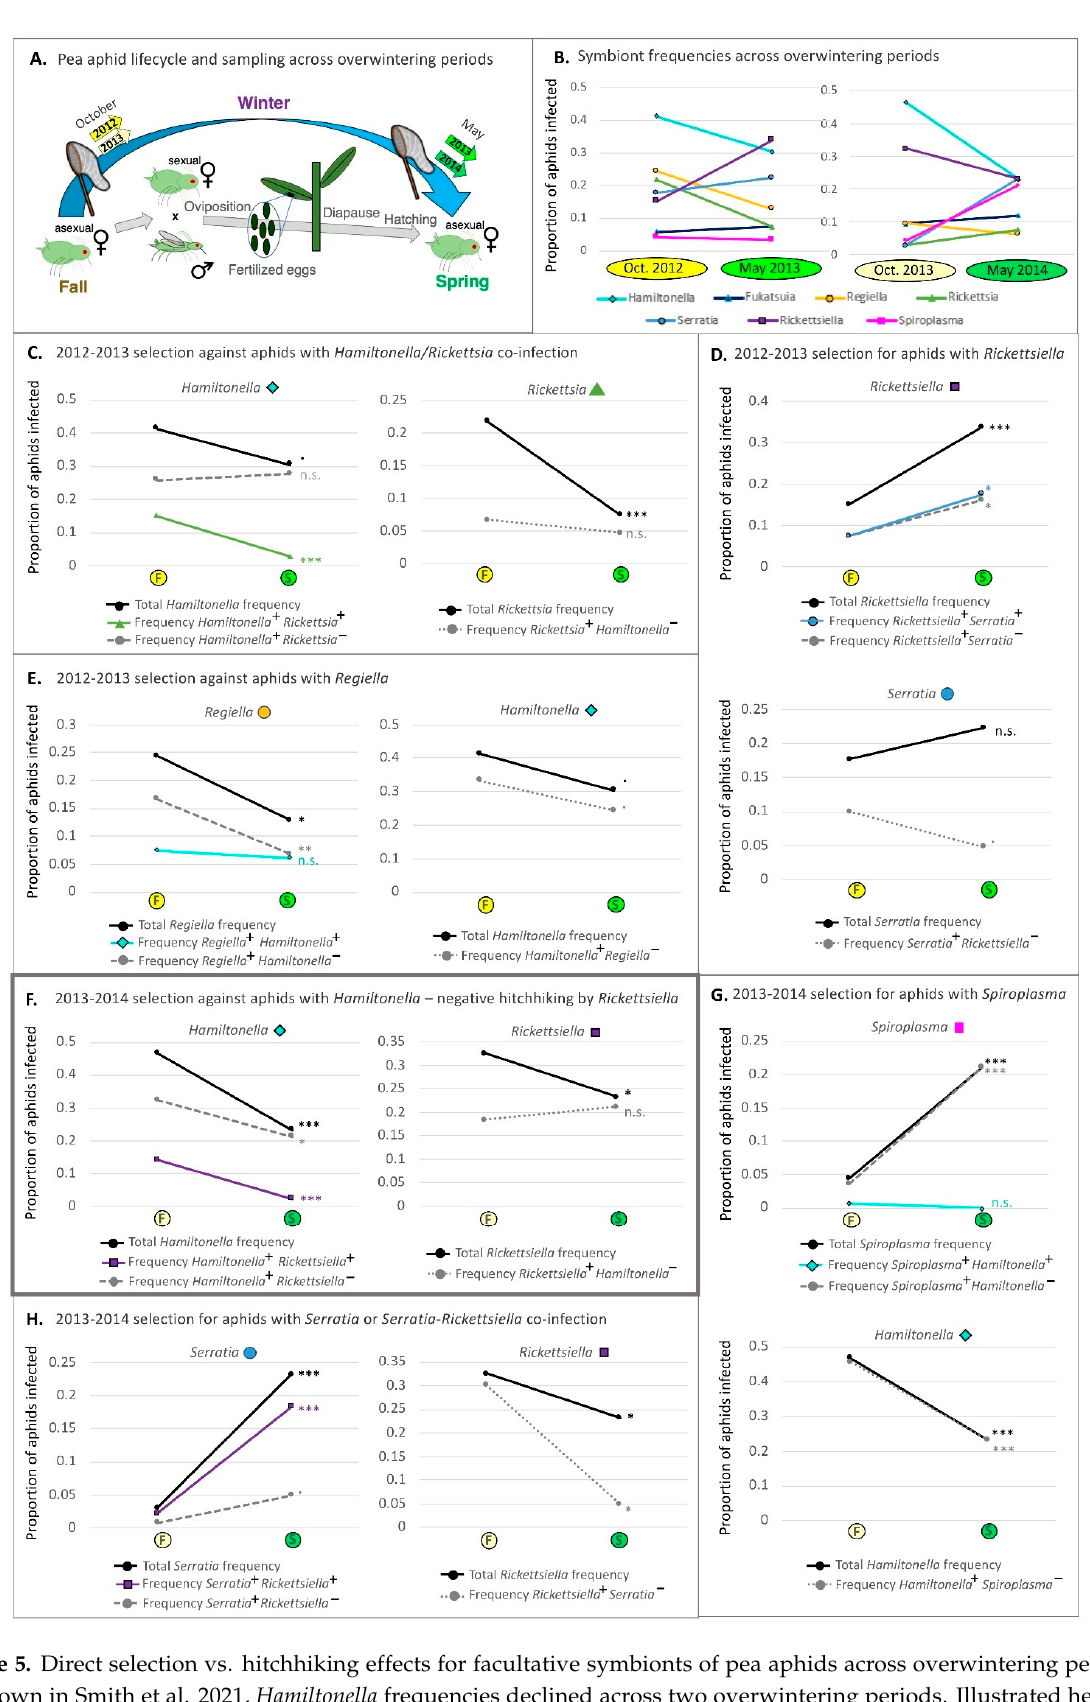
Figure 5. Direct selection vs. hitchhiking effects for facultative symbionts of pea aphids across overwintering periods. As shown in Smith et al. 2021, Hamiltonella frequencies declined across two overwintering periods. Illustrated here, in addition to Hamiltonella , are dynamics for the other six symbionts. Unlike Hamiltonella , none showed consistent